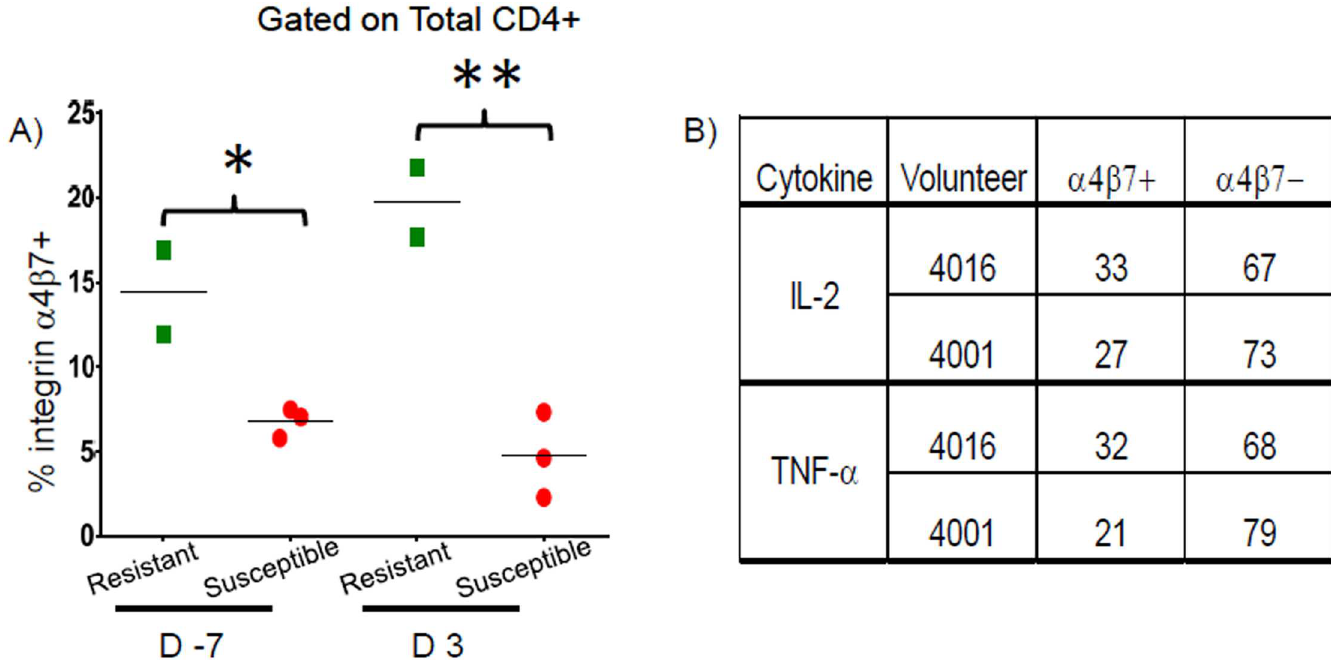
Fig 3. Percentages of total CD4+ expressing integrin α 4 β 7in Resistant and Susceptible volunteers and percentages of cytokine responses attributable to integrin α 4 β 7+and integrin α 4 β 7-populations in Resistant volunteers. A) Percentages of total CD4+ T cells expressingintegrin α 4 β 7 followingstimulationwith CFA/I at baseline(D -7) & 3 days post-challenge (D3) are shown. B) Percentages of total CD4+ CFA/I-specific effector responses on day 3 post-challenge attributable to integrin α 4 β 7+and integrin α 4 β 7-subsets in Resistant volunteers. * p < 0.05 ** p <